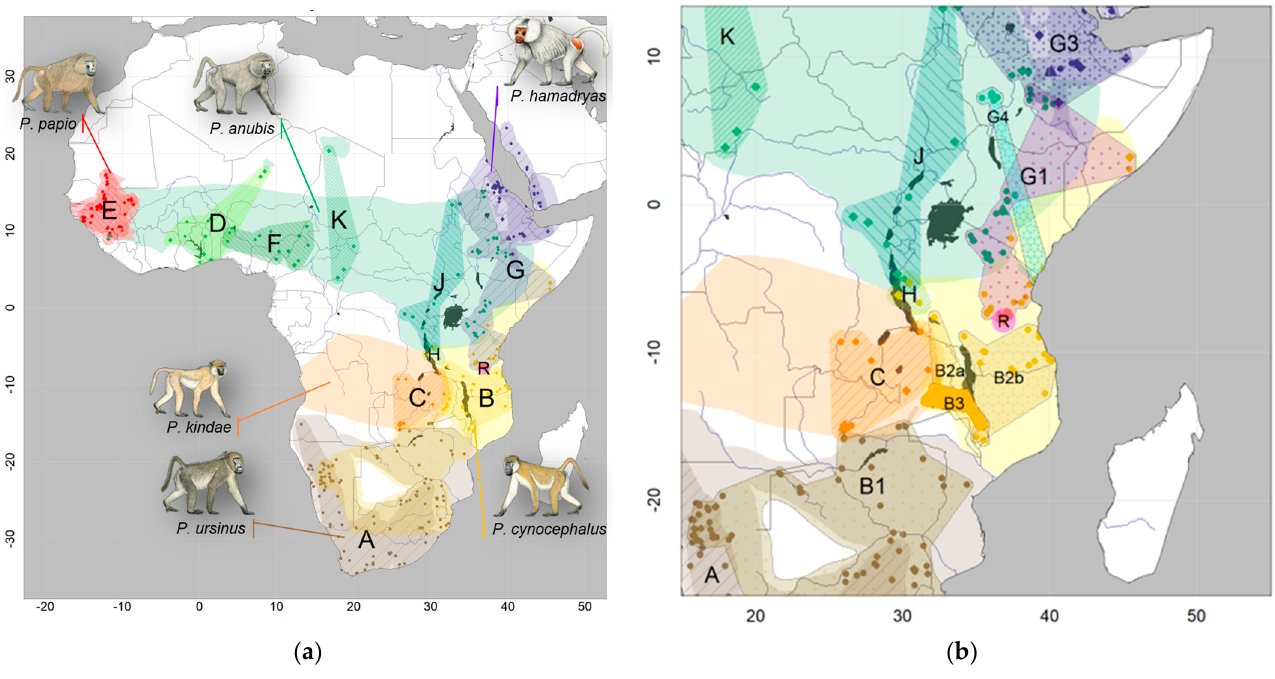
Figure 1. Geographic distributions of the six baboon species: ( a ) Overview of distribution ranges of the six baboon species according to IUCN (2020), colored by species (brown: P. ursinus , yellow: P. cynocephalus , orange: P. kindae , red: P. papio , green: P. anubis , purple: P. hamadryas ). Main mitochondrial clade attributions are indicated by color-patterned regions and denoted with capital letters “A”-”K” and “R”. Circles, diamonds, and triangles represent the provenance of mtDNA markers, mitogenomes, and complete nuclear genomes, respectively, and are colored by species. ( b ) Close-up of the distribution of mitochondrial clades in the eastern distribution of baboons. Male baboon drawings by Stephen Nash, used with permission.